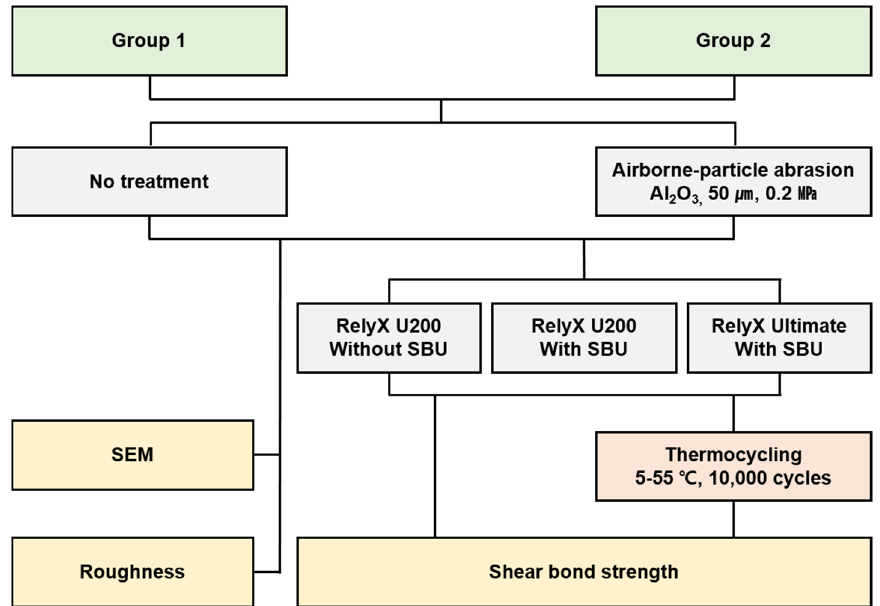
Figure 1. Process flow diagram of the adopted methodology.